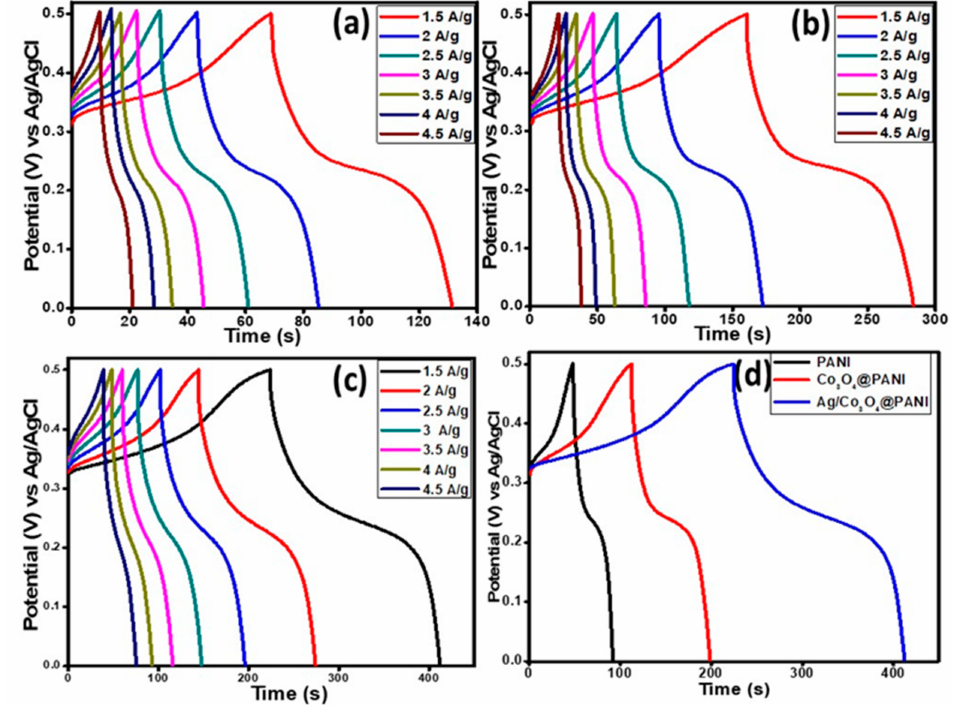
Figure 8. Galvanostatic charge–discharge (GCD) graph at various current densities, ( a ) PANI, ( b ) Co 3 O 4 / @PANI, ( c ) Ag / Co 3 O 4 @PANI, and ( d ) comparison of GCD curves for all three variants at a current density of 1.5 A · g − 1